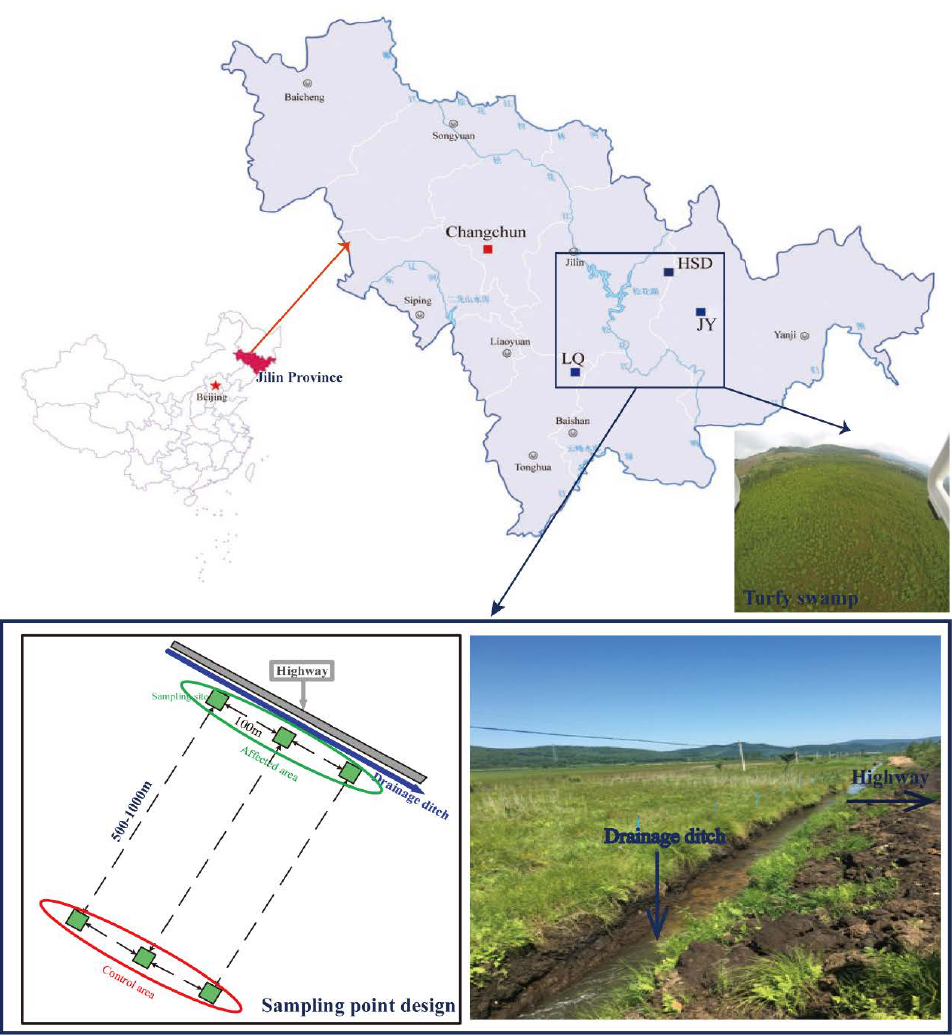
Figure 1. Study area and sampling points design.